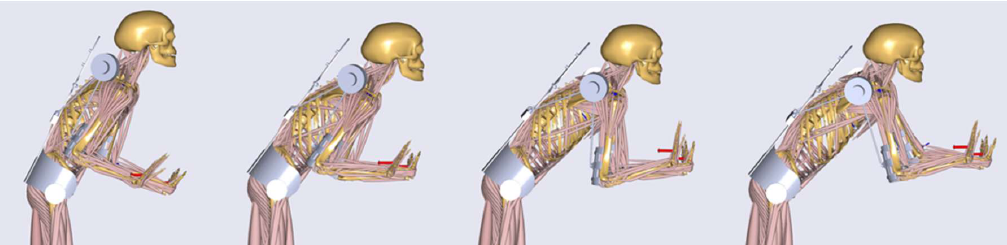
Figure 15. Musculoskeletal evaluation exoskeleton–human model in the push movement sequence.